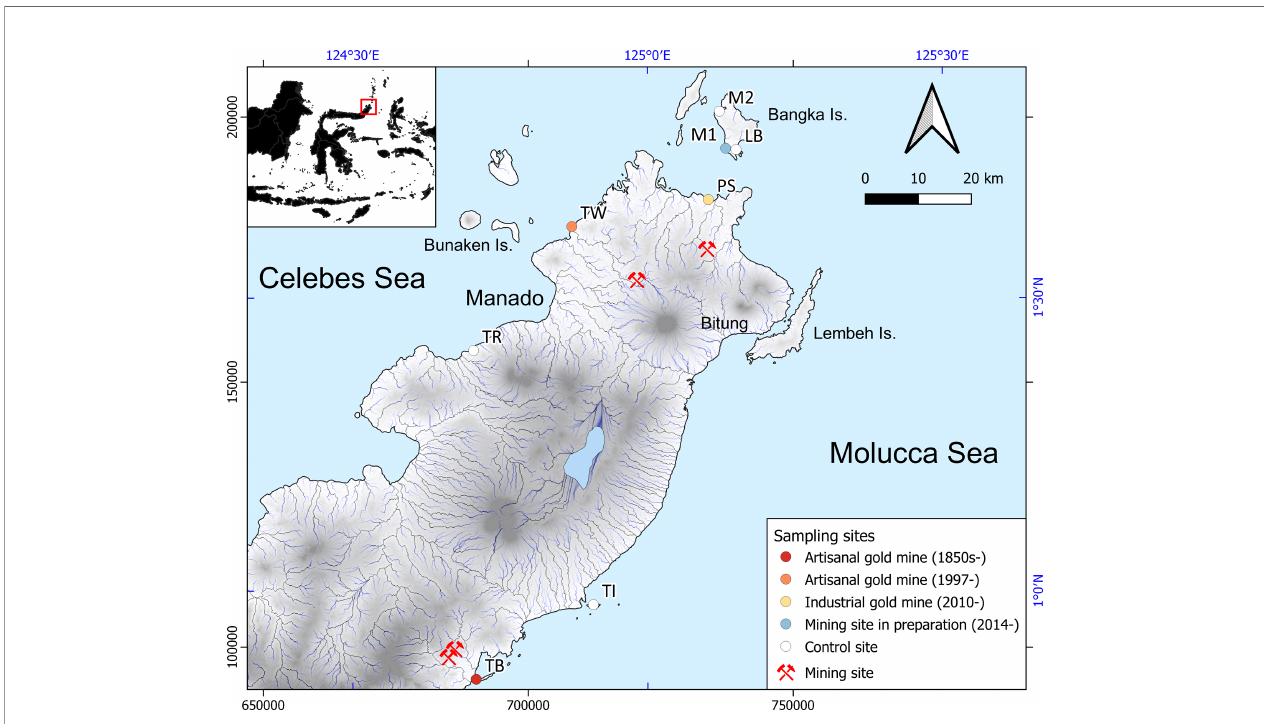
FIGURE 1 | Map of the study area and sampling sites (Datum WGS84, Projection UTM zone 51). Included active gold mines: Totok Bay (TB); Talawaan River (TW); Pantai Surabaya (PS); Mining site in preparation: West Bangka mangroves (M1); Control sites: Lihunu Bay (LB); North-west Bangka mangroves (M2); Tumbak Island (TI); Tasik Ria Resort